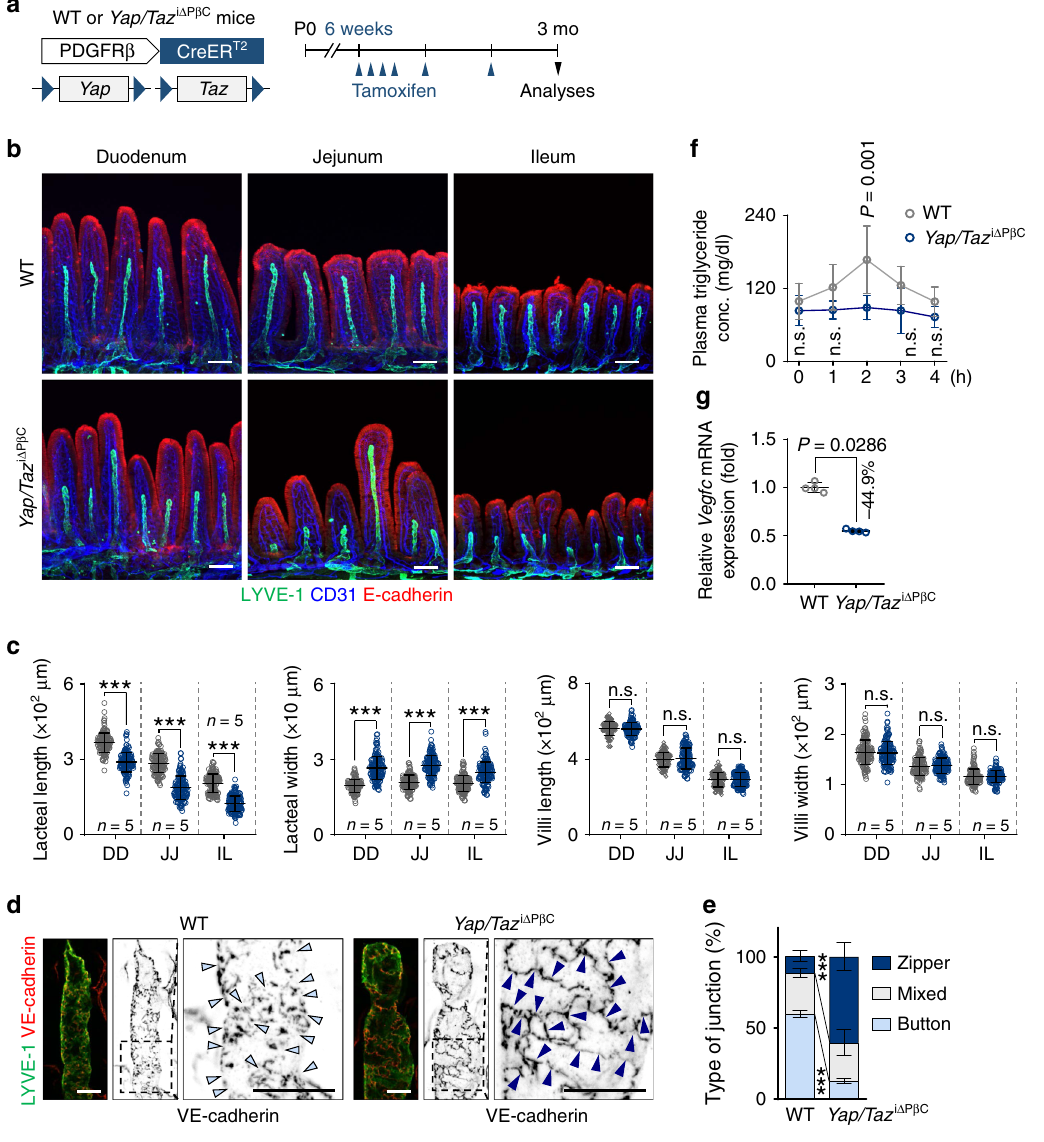
Fig. 4 Regression of lacteal and attenuated Vegfc in intestinal villi of Yap/Taz i Δ P β C mice. a Diagram depicting the generation of Yap / Taz i Δ P β C mouse and PDGFR β + cell-speci fi c depletion of Yap / Taz in small intestinal villi starting at 6 weeks and their analyses at 3 months after tamoxifen treatment. b , c Representative images of LYVE-1 + lacteals and CD31 + capillary plexus under the E-cadherin + intestinal epithelial cells and comparisons of the lacteal length, lacteal width, villi length, and villi width in duodenum (DD), jejunum (JJ), and ileum (IL) of the indicated part of small intestine in WT and Yap / Taz i Δ P β C mice. Dots indicate values from 134~159 villi/group from three independent experiments using n = 5 mice/group. Horizontal bars indicate mean ± SD and *** P < 0.0001 versus WT by two-tailed Mann – Whitney U test. n.s., not signi fi cant. Scale bars, 100 μ m. d , e Representative images and comparison of VE-cadherin + lymphatic endothelial cell (LEC) junctions of LYVE-1 + lacteals in the villi of WT and Yap/Taz i Δ P β C mice. Arrowheads indicate the button-type (WT) or zipper-type dominant junctional pattern ( Yap/Taz i Δ P β C ). Horizontal bars of each colored segment represent mean ± SD of 5~10 villi/mouse and n = 5 mice/group pooled from three independent experiments. *** P < 0.0001 versus WT by two-way ANOVA with Holm – Sidak ’ s multiple comparisons test. Scale bars, 20 μ m. f Plasma triglyceride concentration (mg/dl) at the indicated time points after gavage of 200 μ l of olive oil following fasting for 12 h in WT and Yap/Taz i Δ P β C mice. Each dot indicates a value from n = 6 (WT) or n = 5 ( Yap/Taz i Δ P β C ) mice pooled from three independent experiments. Horizontal bars indicate mean ± SD and P value versus WT by two-way ANOVA with Bonferroni ’ s multiple comparisons test. g Comparison of Vegfc mRNA expression in the intestinal villi lysates of WT and Yap/Taz i Δ P β C mice. Fold changes in mRNA expressions relative to the levels of WT mice are presented. Each dot indicates a value obtained from one mouse and n = 4 mice/group pooled from three independent experiments. Horizontal bars indicate mean ± SD and P value versus WT by two-tailed Mann – Whitney U